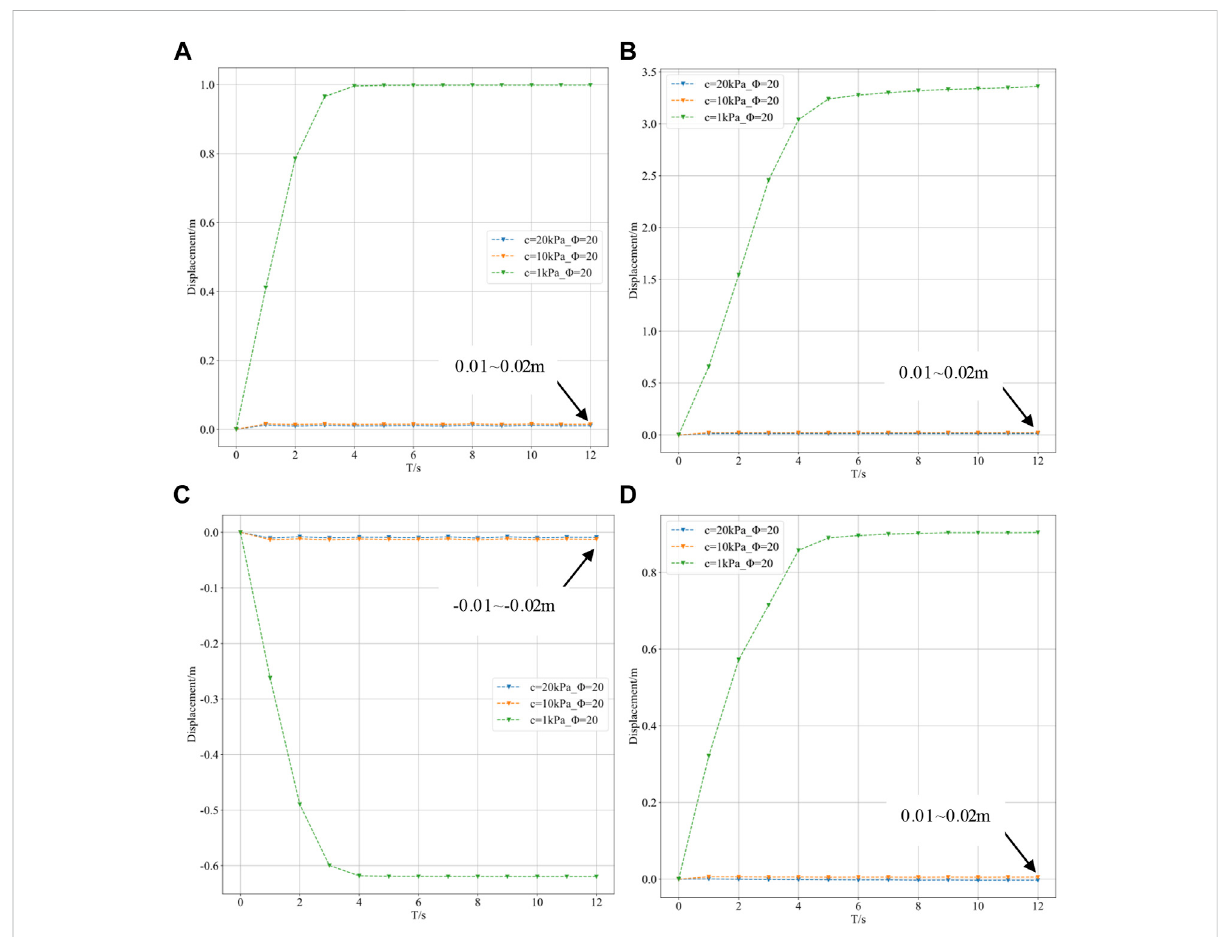
FIGURE 7 The displacement variation curve of the monitoring points. (A) Displacement variation curve of the slope shoulder. (B) Displacement variation curve of the slope foot. (C) Vertical displacement variation curve of the slope shoulder. (D) Vertical displacement variation curve of the slope